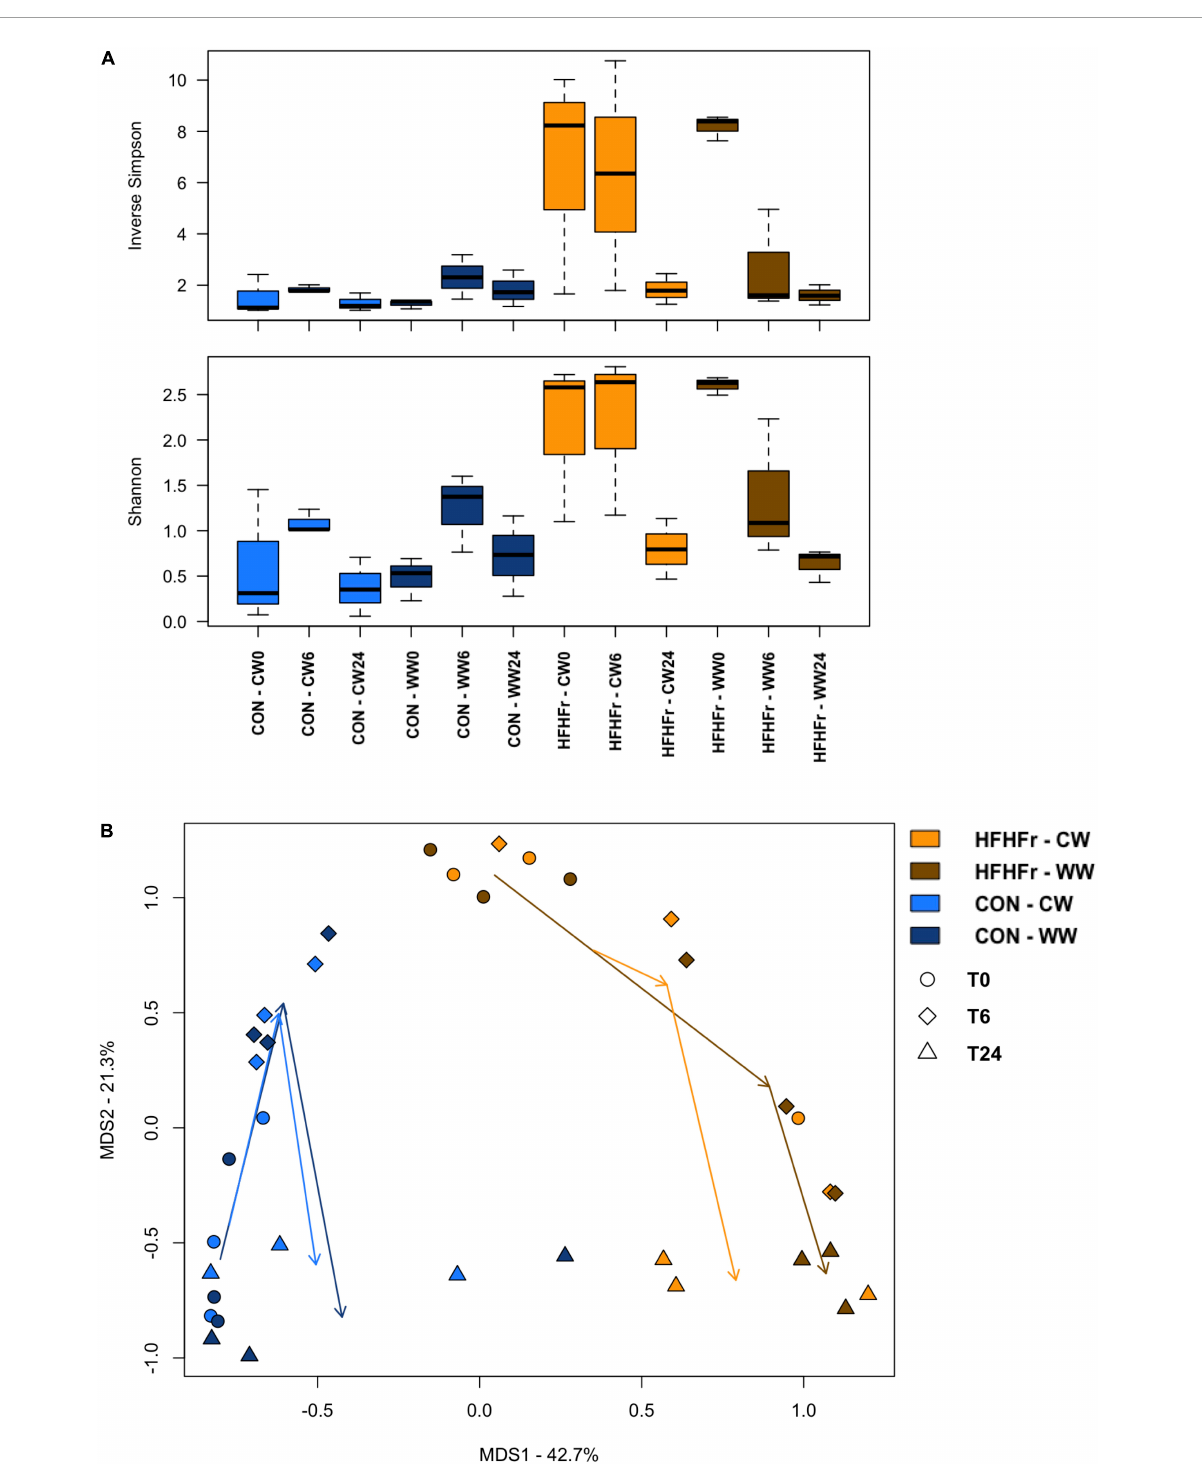
FIGURE2 The gut microbiota of mice fed a high-fat high-fructose diet vs. control mice following in vitro fermentation with wholegrain and control wheat. (A) Boxplots showing the distribution of alpha diversity, according to the inverse Simpson (top) and Shannon (bottom) index, in fermentation samples from mice fed a high-fat high-fructose diet (HFHFr) and control mice (CON) collected at 0, 6, and 24 h after fermentation with digested wholegrain wheat (WW) or control wheat (CW). No significant differences were found over time. (B) Principal Coordinates Analysis (PCoA) of beta diversity, based on Bray-Curtis dissimilarity, showing all fermentation samples. A significant separation was found between groups, regardless of experimental condition (WW, CW) and time point (0, 6, and 24 h) ( P = 1 × 10 − 4 , permutation test with pseudo-F